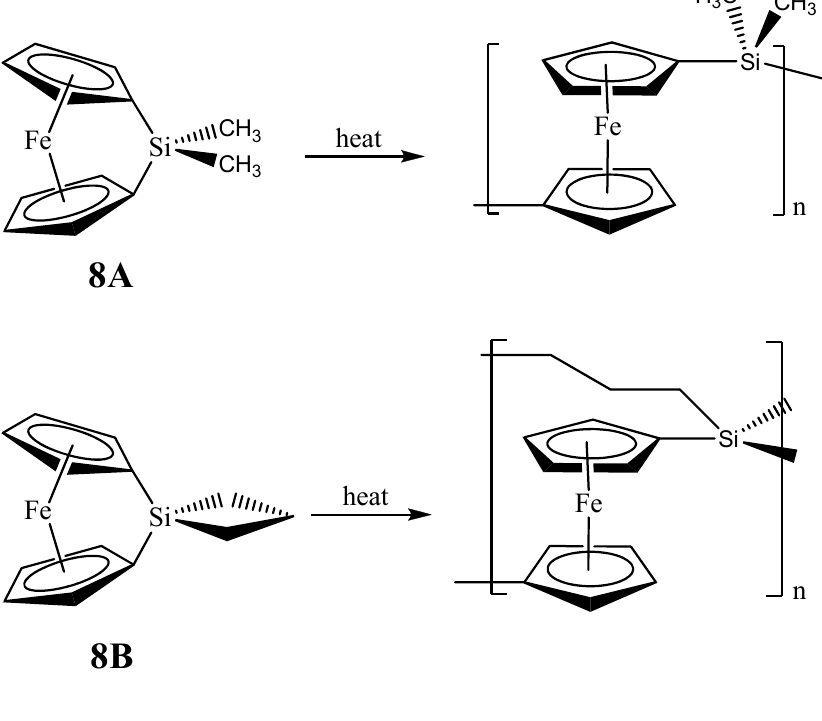
Figure 6. Ring opening polymerizations (ROP) of 1,1-ferrocenylene(dimethyl)silylene ( 8A ) and spirocyclic[1]-ferrocenophane ( 8B ) that produce the respective crosslinked networks. Adapted from Ref. [68] with permission from American Chemical